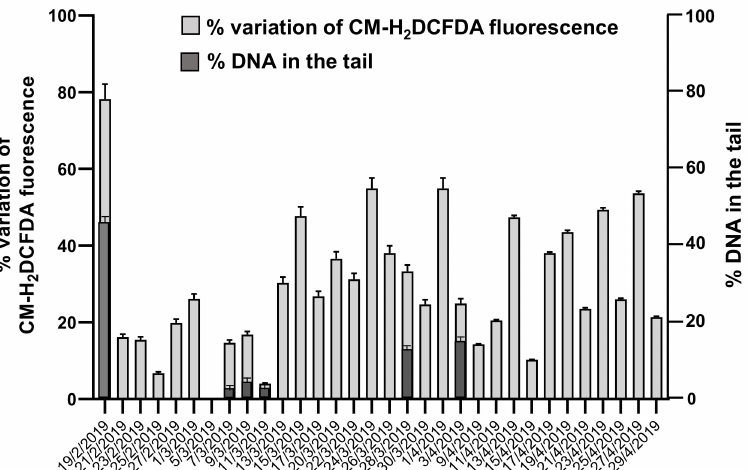
Figure 4. Intracellular oxidative stress (expressed as % variation of CM-H 2 DCFDA vs. negative control) measured in A549 cells exposed for 24 h to the PM 10 aqueous extracts are shown by light gray bars. Data are referred to the entire set of samples. Genotoxicity (expressed as % of DNA in the tail of the comets) measured by the A549 cells exposed for 24 h to the PM 10 aqueous extracts are shown by dark gray bars. Genotoxicity data are referred to as a subset of